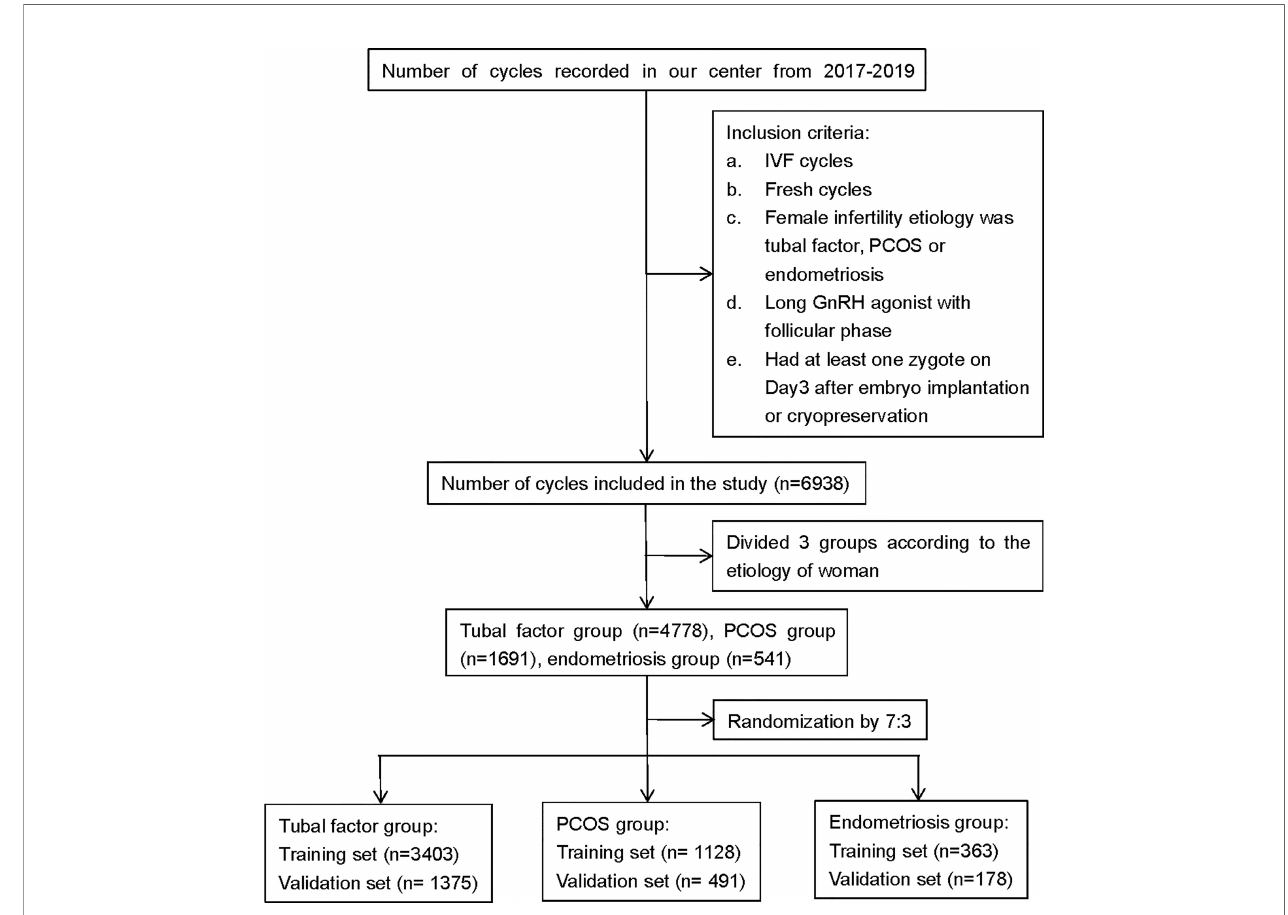
FIGURE 1 | Flowchart showing data selection process. PCOS, polycystic ovary syndrome; GnRH, gonadotropin-releasing hormone; IVF, in vitro